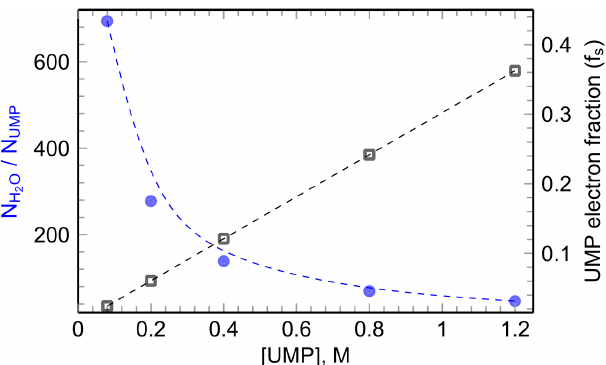
Figure 2. Left axis (blue filled circle): molecular number ratio between water and UMP plotted as a function of UMP concentration in an aqueous environment. Right axis (open box): correlation of the electron fraction ( f s ) with the UMP concentration to indicate the probability of direct-type radiation e ff ect on the nucleotide occurring in the bulk phase. Reprinted with permission from [43]. Copyright, 2018, American Chemical